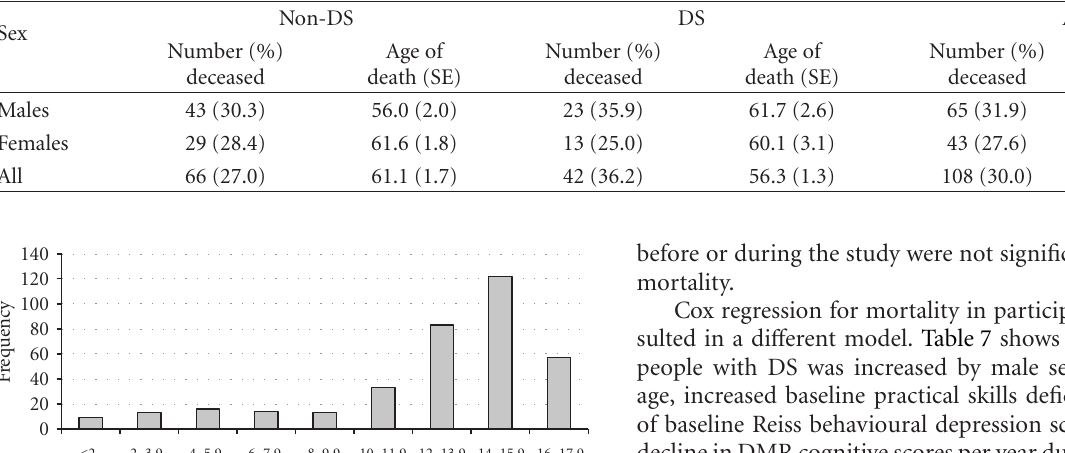
Table 4: Number (%) of the baseline cohort deceased and the mean age of death as of July 2011.